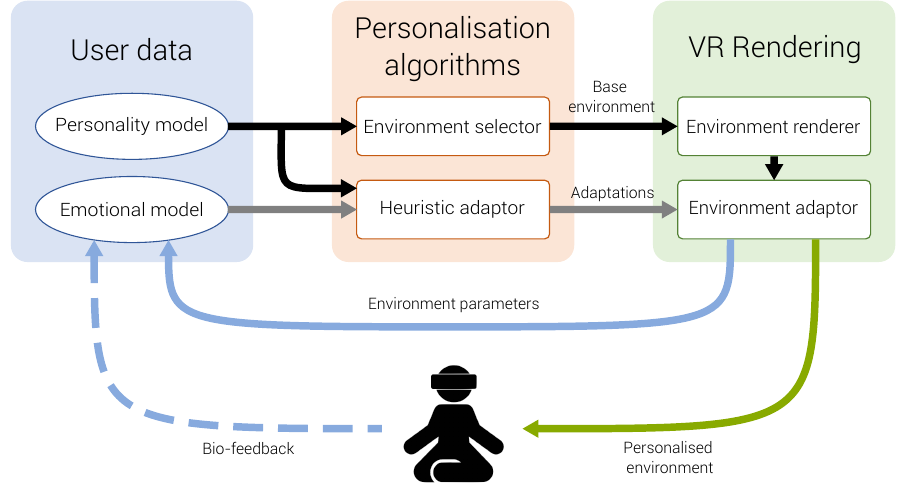
Figure 1. High level view of the